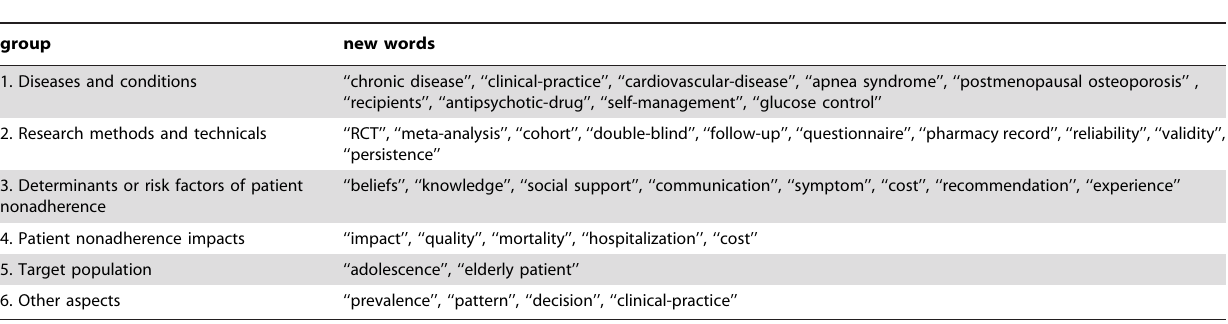
Table 2. Groups of the New Words Emerged during the Second Period.